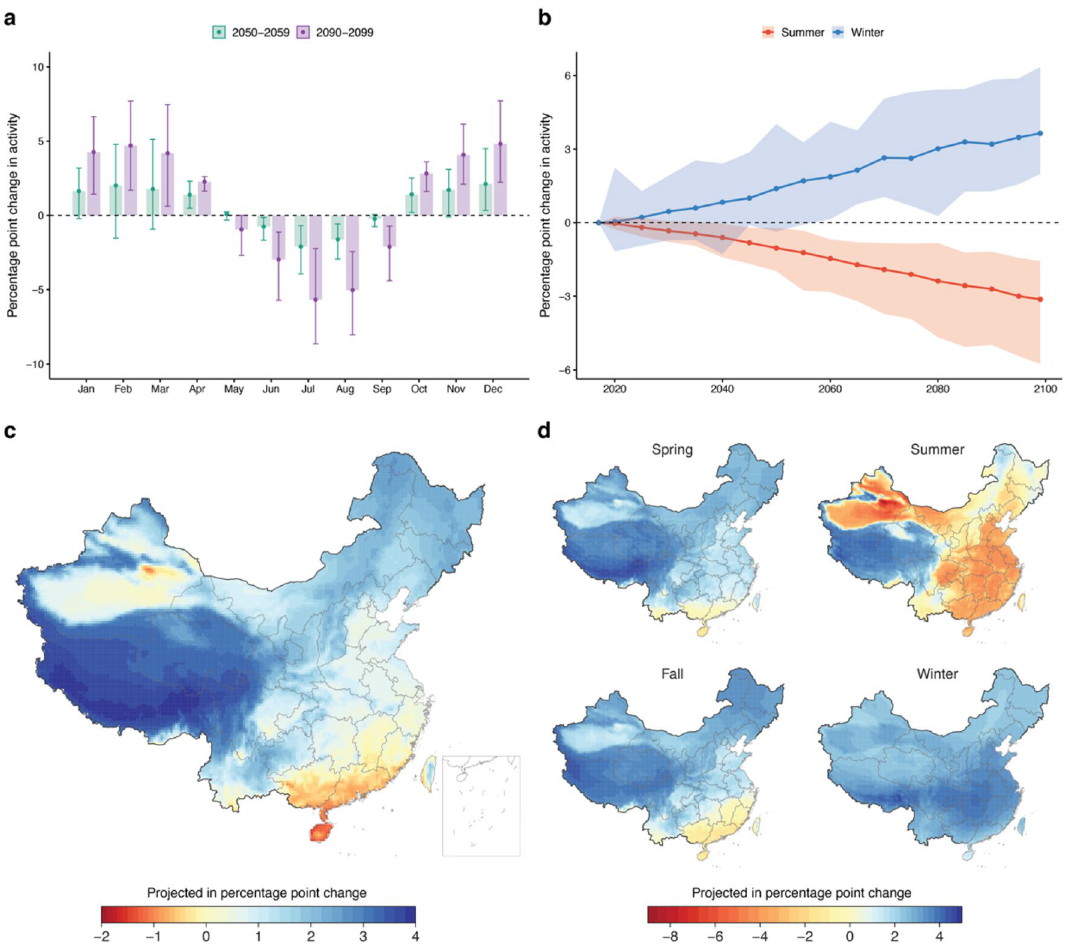
Figure 5. Projected change in park visitation quantity. ( a ) Additional percentage point change in park visitation quantity by month in the years 2050 and 2099 compared with 2017 due to climate change. ( b ) The percentage change in activity quantity for summer and winter respective for all years in the future. Geographic estimates of the projected change in park visitation quantity in all areas of China in 2090–2099 under the RCP8.5 scenario. Error bars and shaded areas represent 95% confidence intervals calculated through Monte Carlo sampling of econometric parameter estimates and climate models. ( c ) Geographic dispersion of the predicted additional yearly average effects of climate change-induced activity change in 2090–2099. (d ) Prediction of additional climate change-induced activity change in 2090–2099 by seasons. Results for the RCP 4.5 scenario are presented in Supplementary Fig. 6. The figure was created using R (version 4.1.0 https:// www.r- proje ct. org/), and the maps do not have a copyright